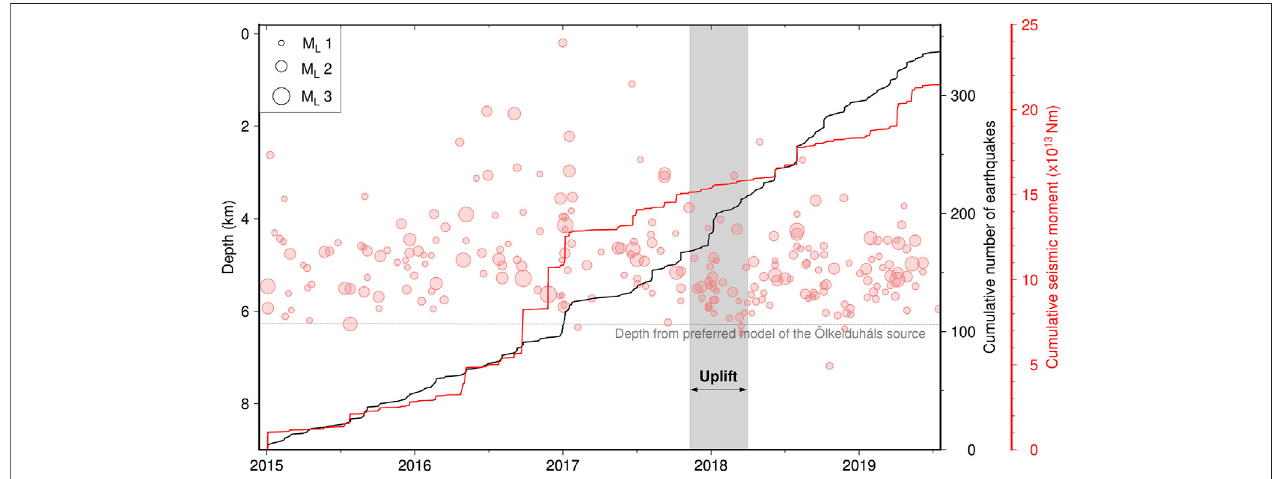
FIGURE 9| Earthquakes focal depths (M L > 1) in the Ölkelduháls region, asa function of time from January 2015to June 2019 from the IMO network. The dashed line presents the depth of the best fi t model of an in fl ation below Ölkelduháls ( Table 2 ). The time span of uplift (2017 – 2018) is highlighted in dark grey (time estimation in Uplift Time Span ). The black line indicates the cumulative number of earthquakes while the red line shows the cumulative seismic moment release. No considerable changes in seismic rates within the time span of the uplift are observable when compared to the prior and following